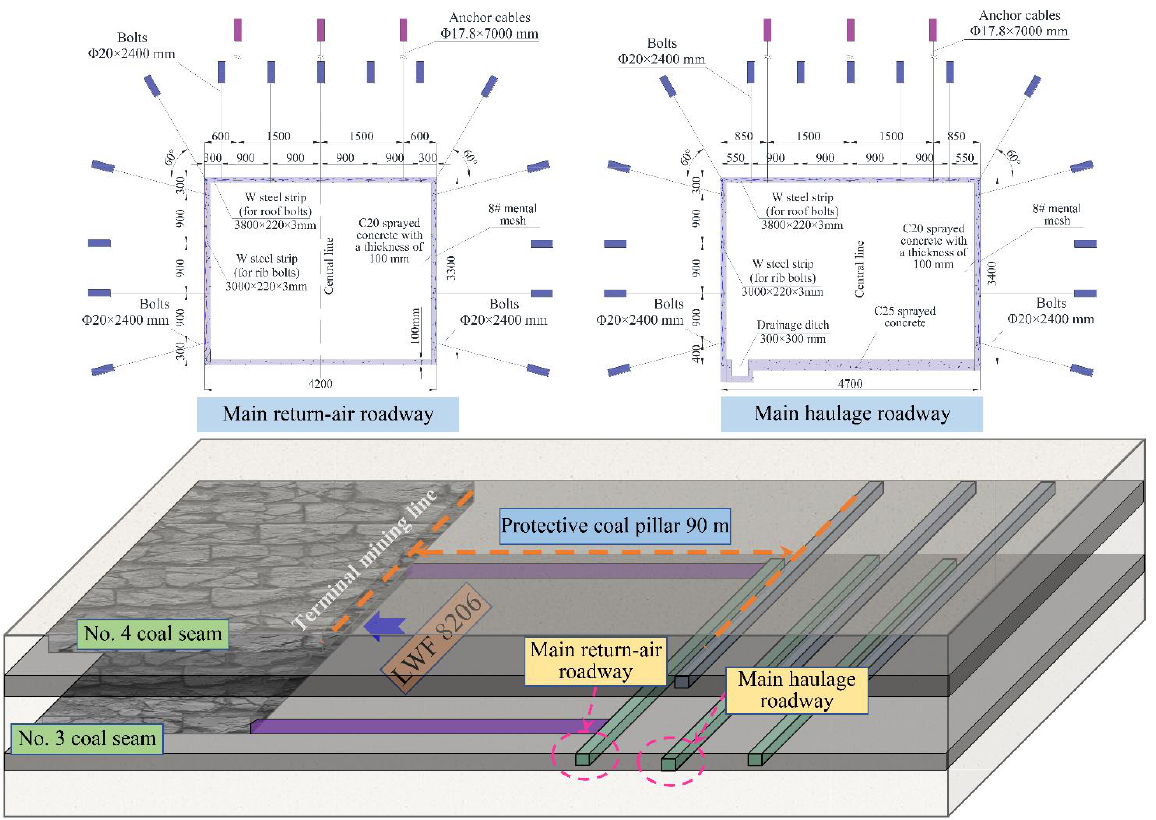
Figure 3. Support parameters of the main roadway group.